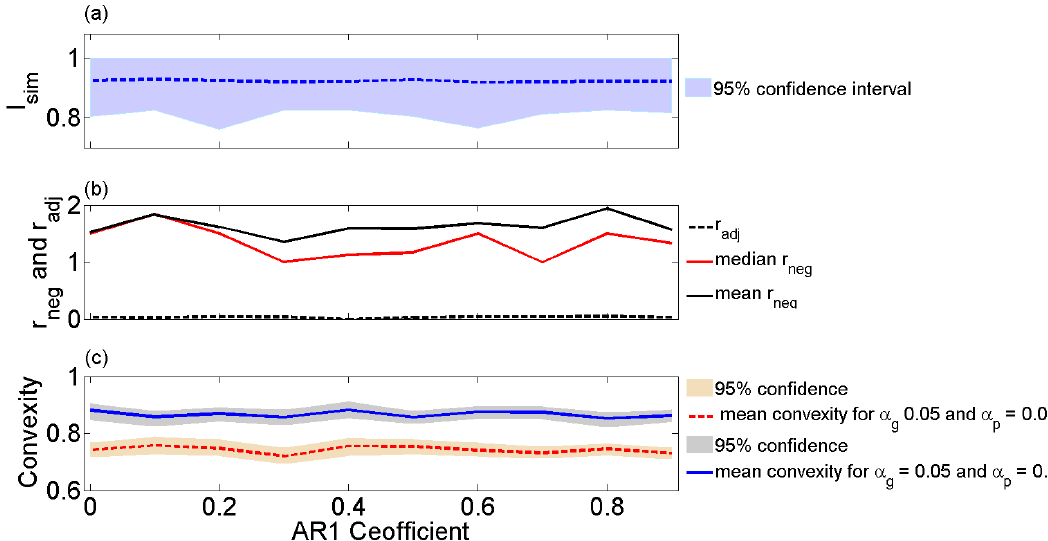
Figure 6. (a) Similarity index between the geometric and areawise tests for different lag-1 autocorrelation coefficients for red-noise processes (see text). (b) Same as (a) except for the ratio between the false positive results of the geometric and areawise tests. The dotted black line represents the ratio of false positive between the two tests when the false discovery rate of the geometric test is controlled at the 0.05 level. (c) Same as (a) but for the mean convexity of 5% pointwise significance patches that are geometrically significant at the 5% level and for the mean convexity of 5% pointwise significance patches that are areawise significant at the 5%